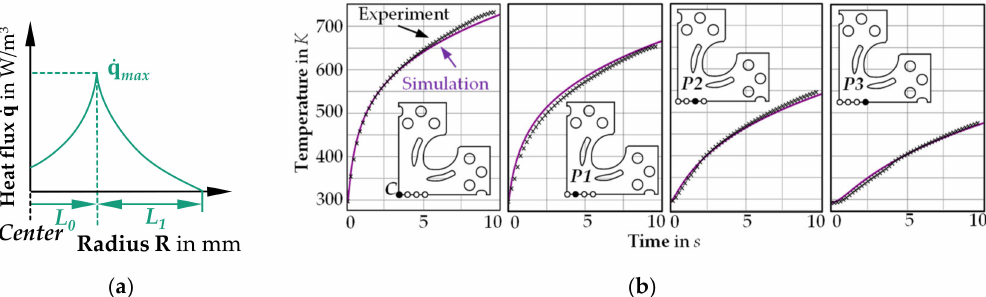
Figure 6. Analytical modeling of the heat source: ( a ) approach for modeling the location-dependent heat flow as a function of the radius; ( b ) comparison of the experimental and simulated temperature-time curves at different evaluation points, using the inversely identified parameters of the heat source model.